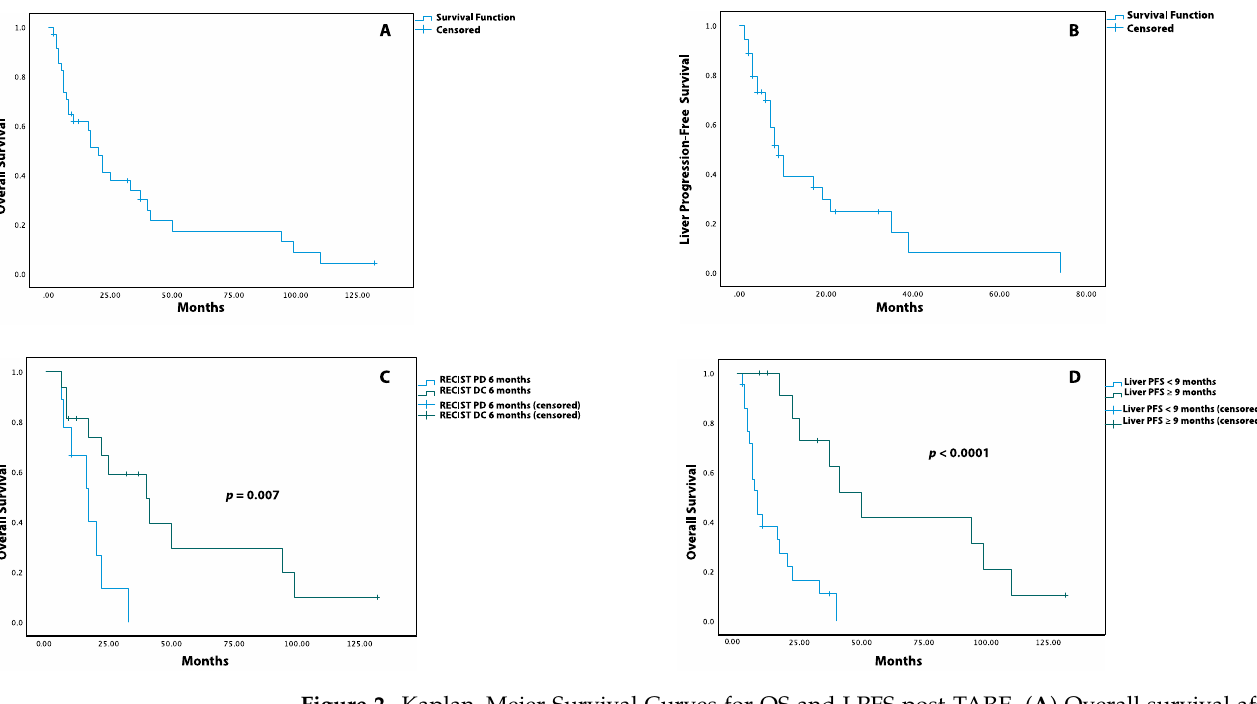
Figure 2. Kaplan–Meier Survival Curves for OS and LPFS post-TARE. ( A ) Overall survival after TARE. ( B ) Liver progression-free survival after TARE. ( C ) Overall survival after TARE in patients with DC (disease control) versus PD (progression of disease) at 6 months when assessed by RECIST criteria. ( D ) Overall survival after TARE in patients with liver PFS equal to or greater than 9 months versus patients with liver PFS lower than 9 months. Table 3. Univariate analysis of overall survival .